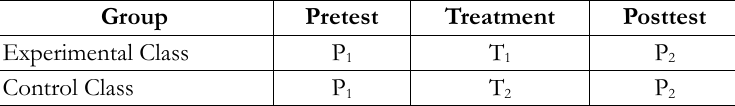
Table 1. Research